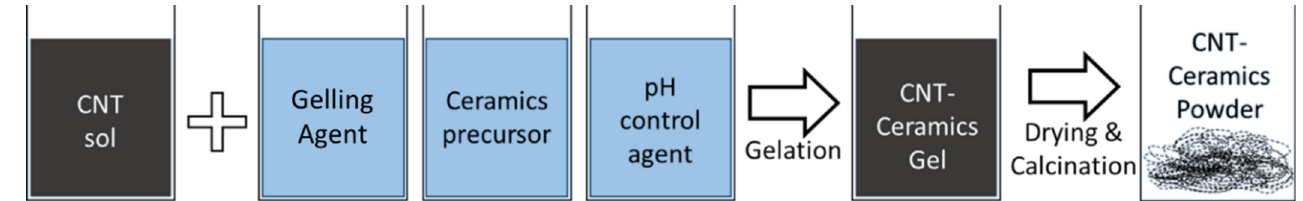
Figure 6. Schematic diagram of CNTs-CMCs sol–gel processing.